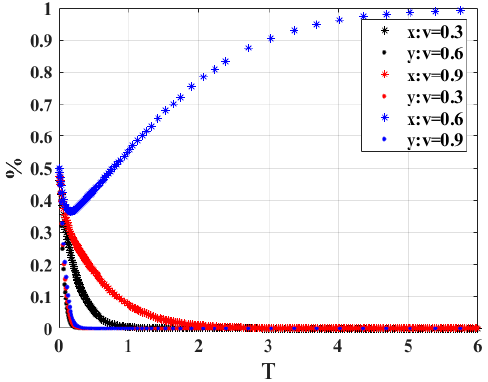
Figure 4. Sensitivity analysis of “ v ”.